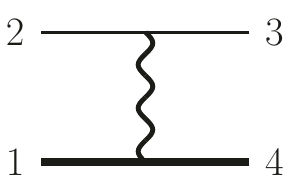
Figure 2 . The tree-level amplitude that captures the O ( G ) spin interactions. The thick (thin) straight line represents the spinning (scalar) particle, while the wiggly line corresponds to the exchanged